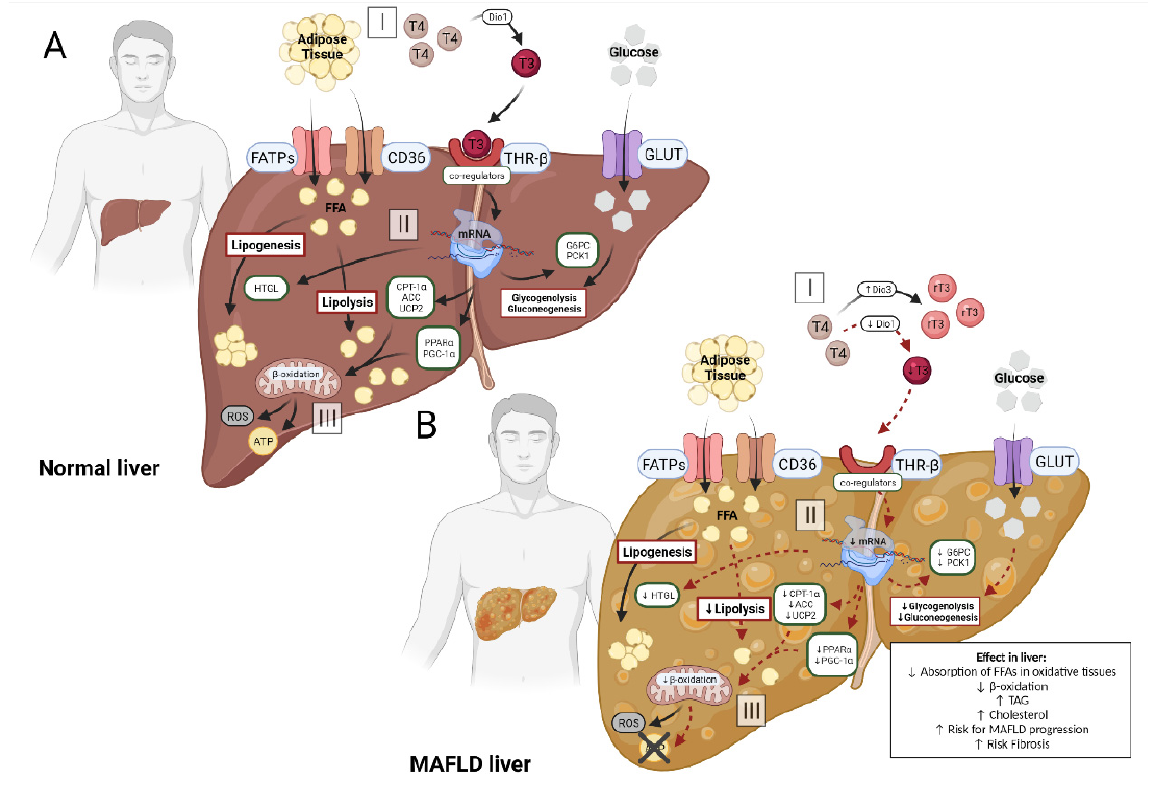
Figure 2. ( A ): In the normal liver, circulating adipose tissue enters the hepatocyte via specific receptors, FATPs and CD36 (A-I). At the same time, the circulating hormone T4 is converted into T3 by the enzyme Dio1, making it biologically active and enabling its binding to its THR β receptor (A-I). This attachment generates the activation of co-regulators, which could stimulate the transcription of genes in the hepatocyte (A-II). The main genes activated in this process are CPT-1 α , UCP2, PGC-1 α and PPARs, increasing hepatic lipolysis and β -oxidation, and ATP production (A-III). Other genes that are indirectly stimulated are HTLG linked to the process of lipogenesis and genes linked to glycogenolysis and gluconeogenesis, G6PC and PCK-1, using the serum glucose that entered the hepatocyte via the specific transporter GLUT (A-II). ( B ): In the MAFLD liver, the process is changed. Circulating adipose tissue enters the hepatocyte via FATPs and CD36 (B-I). However, circulating T4 does not convert into T3, but into rT3 or T2, due to the reduction of Dio1 activity and the increase of Dio3, decreasing the binding of the hormone to the THR β (B-I) receptor. With lower availability of T3, the activation of co-regulators does not occur effectively, reducing the transcription of genes in the hepatocyte (B-II). Among the affected genes are CPT-1 α , UCP2, PGC-1 α and PPARs, decreasing hepatic lipolysis and β -oxidation, reducing ATP production and increasing reactive oxygen species (ROS) (B-III). Other genes also affected alter the process of lipogenesis and decrease glycogenolysis and gluconeogenesis (B-II). This imbalance of hepatic metabolism is one of the main factors involved in the progression of MAFLD, with a high risk of fibrosis.